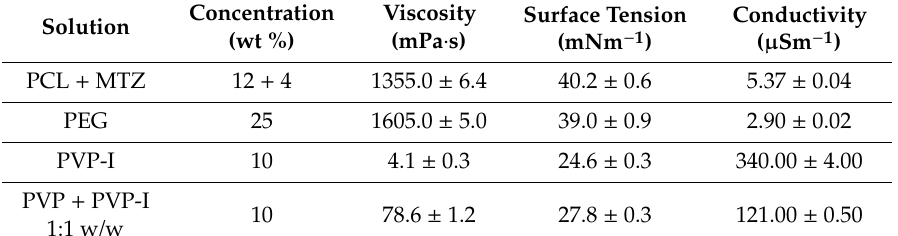
Table 2. Physical properties of the electrospinning solutions used to generate trilayered fibers.